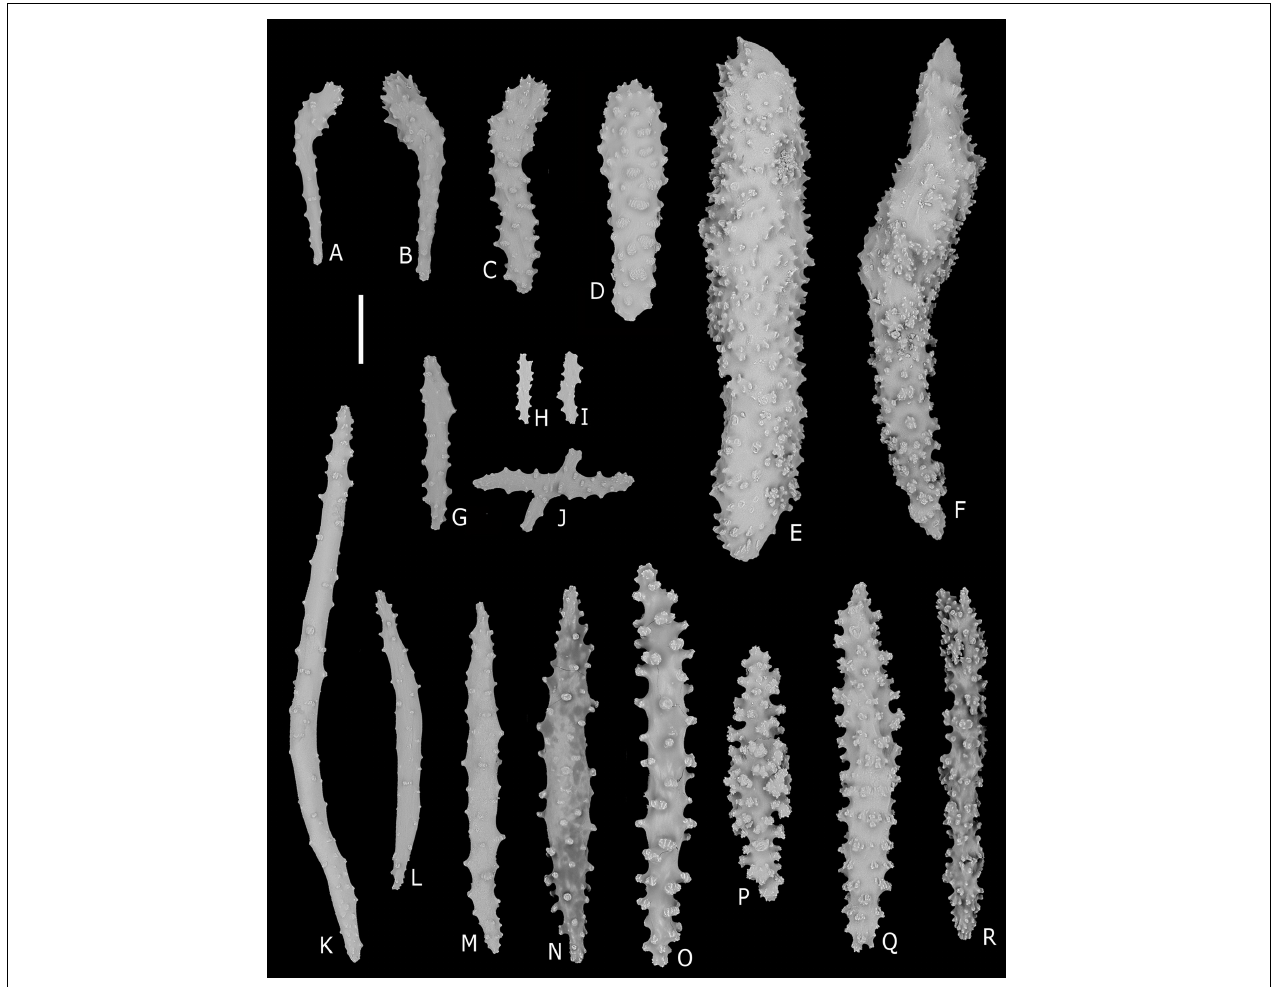
FIGURE 2 | Common sclerites found in Victorgorgia López-González and Briand, 2002. (A,B) Josephinae clubs from the tentacle rachis. (C) Club from the tentacle rachis. (D,E) Squat tuberculate rods from the tentacle rachis. (F) Thorn club from the tentacle rachis. (G) Tuberculate stick from the pinnules. (H,I) Flat jagged rods from the pinnules. (J) Cross from the pinnules. (K–R) Smooth to heavily tuberculated spindles and sticks from the points, collarets, calyces, cortex and medulla. Scale bar = 100 µ